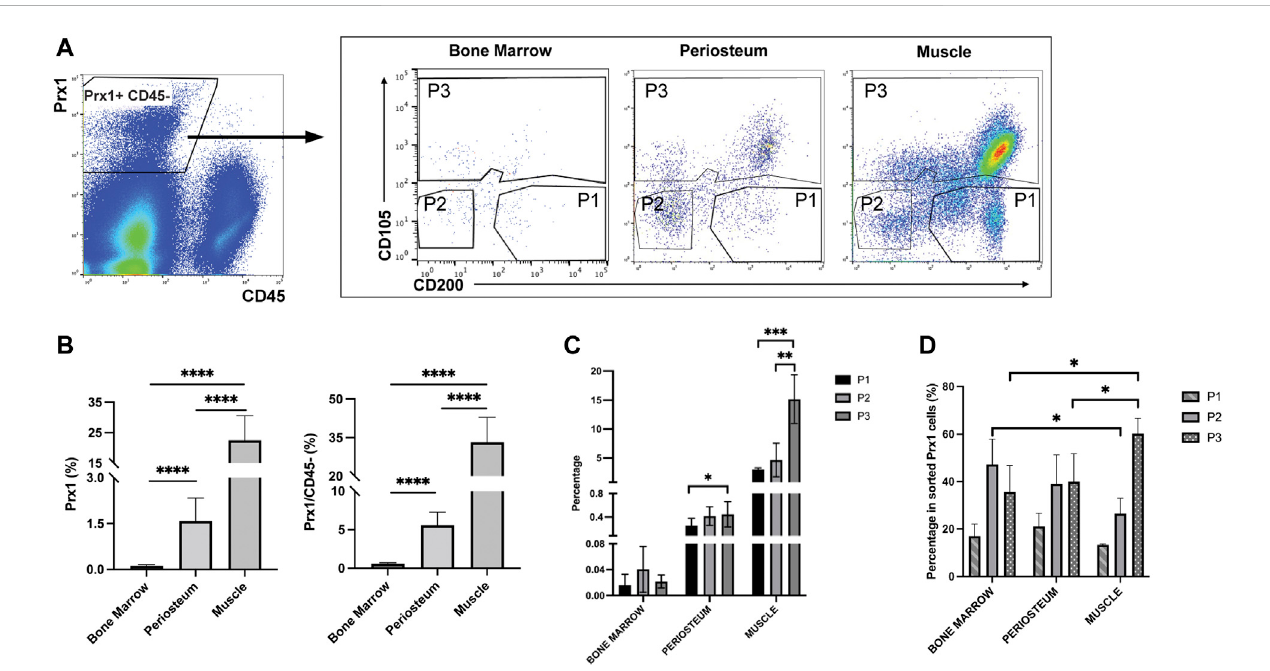
FIGURE 4 Flow cytometry analyses of bone marrow, periosteum and muscle cells isolated from Prx1CreER-GFP/Ai14/Rag1mice. (A) . Prx1-derived cells were harvestedbasedontdTomatoexpression.AfterexcludingCD45 + cells,3subpopulations weresubsequentlyisolatedbasedonCD105andCD200expression. (B) . Quanti fi cation of Prx1+ cells harvested from bone marrow, periosteum and muscle. The percentages were calculated based on live cells or CD45-cells. (C) . Percentage of P1, P2, P3 cells of all live cells harvested from bone marrow, periosteum and muscle. (D) . Percentage of P1, P2, P3 cells of Prx1+ population harvested from bone marrow, periosteum and muscle. One-way ANOVA was performed followed by Tukey test to assess statistical signi fi cance. * p < 0.05, ** p < 0.01, *** p < 0.001, **** p < 0.0001. n = 6. Data represent mean ±